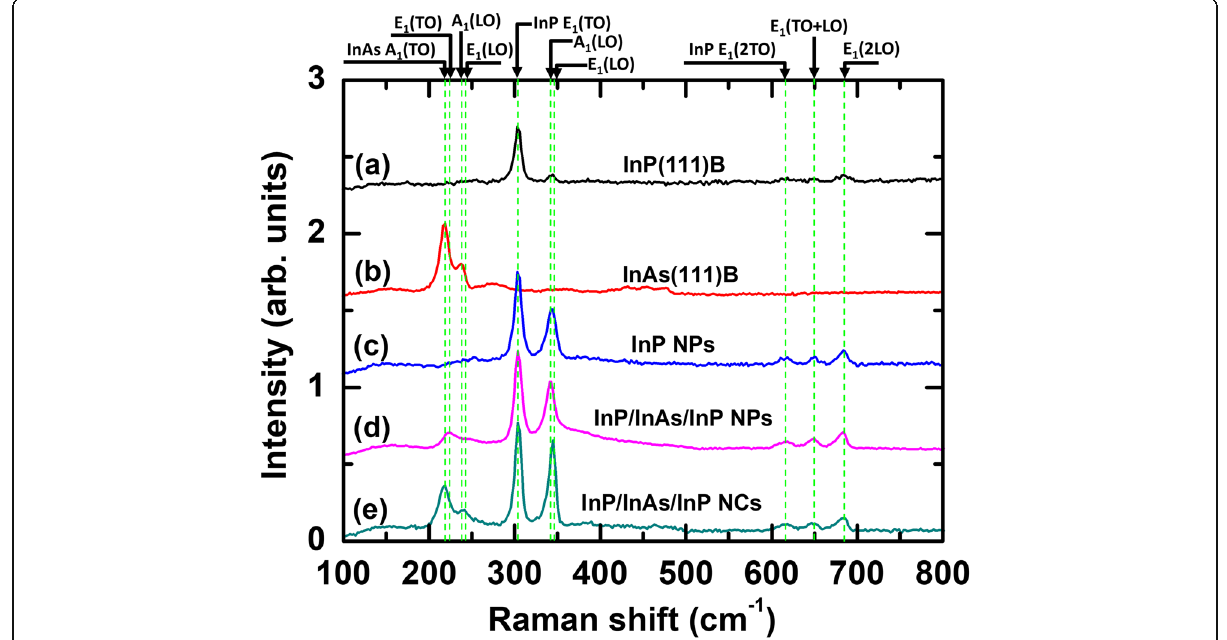
Fig. 2 Raman spectra of ( a ) InP(111)B crystal, ( b ) InAs(111)B crystal, ( c ) InP nanopillar, ( d ) InP/InAs/InP nanopillar, and ( e ) InP/InAs/InP nanocones. The green dot lines are corresponded to InAs A 1 (TO), InAs E 1 (TO), InAs A 1 (LO), InAs E 1 (LO), InP E 1 (TO), InP A 1 (LO), InP E 1 (LO), InP E 1 (2TO), InP E 1 (TO+LO), and InP E 1 (2LO) in